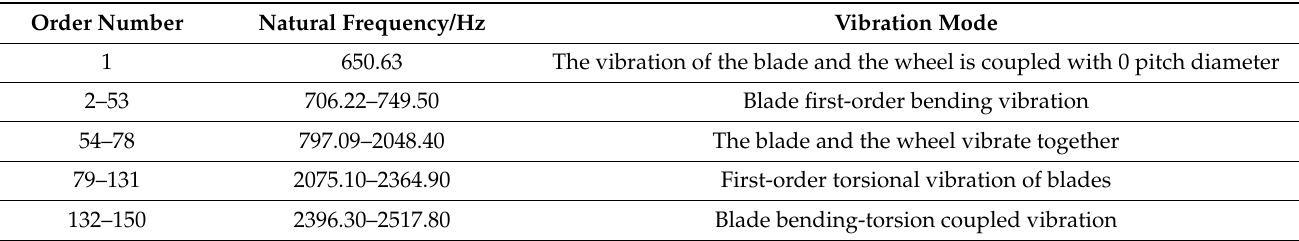
Table 7. First 150 order natural frequencies and mode shapes of stage 2 blading disk systems.